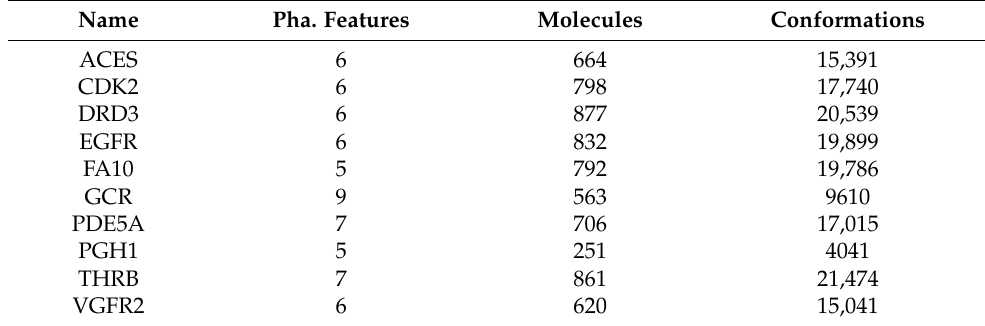
Table 1. Summary of benchmarking